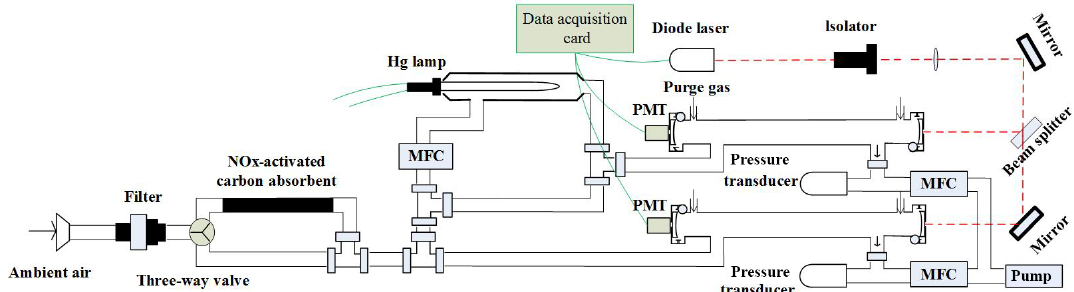
Figure 1. Schematic of the dual-channel cavity ring-down spectroscopy system.